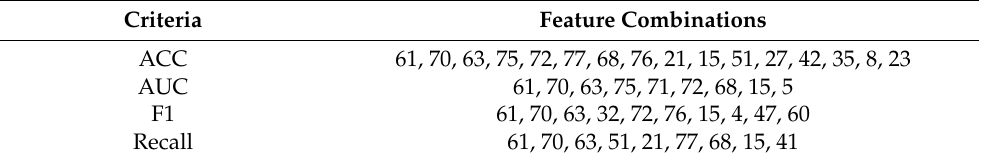
Table 6. Feature combination by GSFTS-FS.